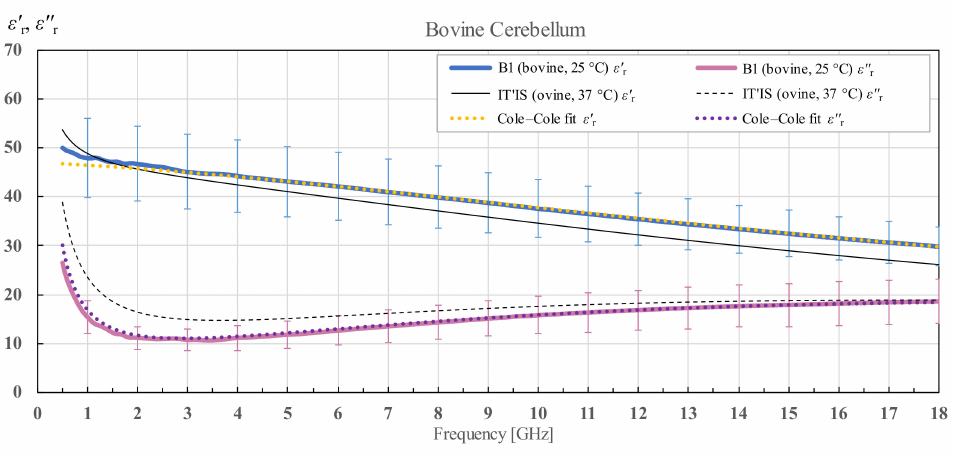
Figure 13. Permittivity of bovine cerebellum for brain B1 with standard deviation and Cole–Cole fit, shown in comparison with the data from IT’IS database [21].